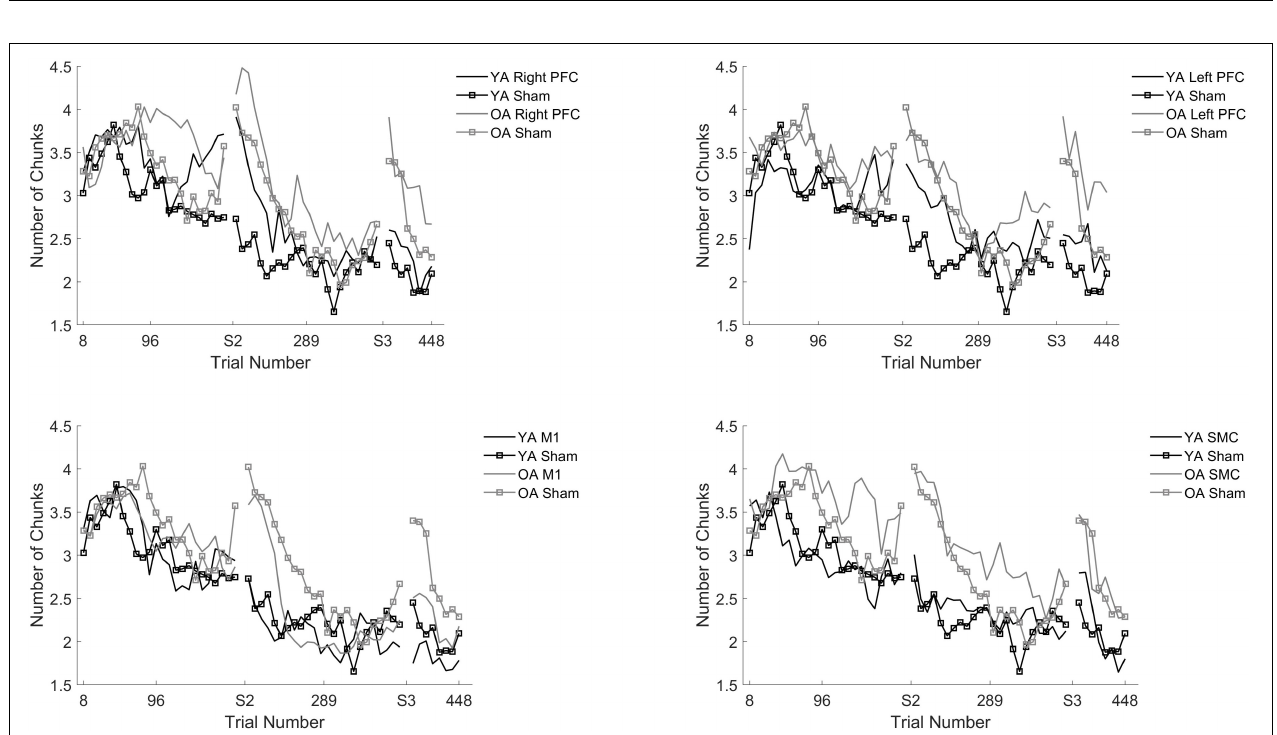
FIGURE 4 | Averaged reaction time for young (black) and older adults (gray) for each tDCS group within each practice session. Each panel represents one session. Error bars represent standard deviation.